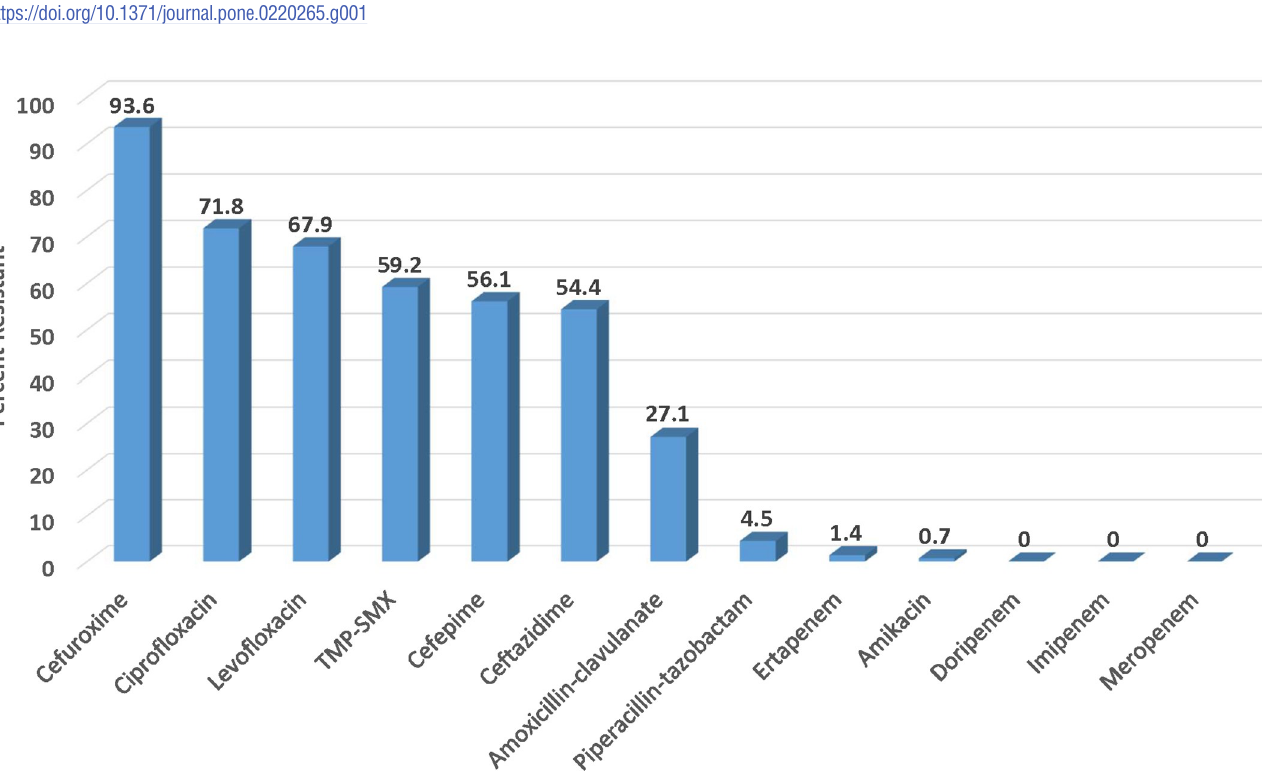
PLOS ONE | https://doi.org/10.1371/journal.pone.0220265 December10, 2019 5 /